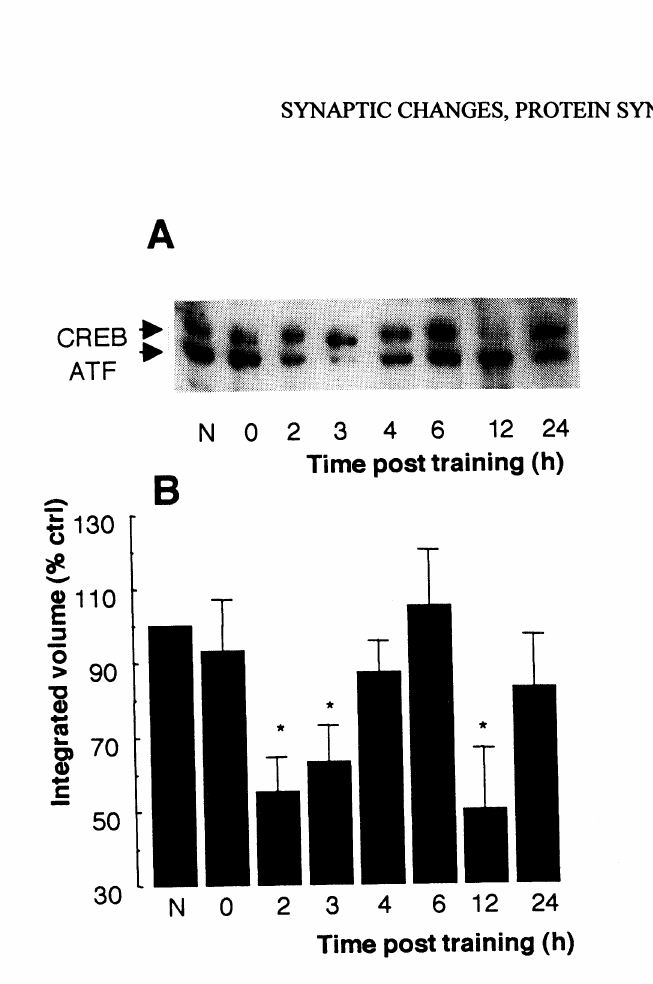
Fig. 2: Regulation of phosphoCREB expression in the hippocampal dentate gyrus following passive avoidance training. Animals were sacrificed at the indicated times post-training, the dentate gyrus was homogenised and immunoblot analysis with antibody to phosphoCREB was performed on nuclear extracts. Panel A shows a representative immunoblot. Semi-quantitative scanning densito- metry is shown in panel B, where values are normalized to % na’fve control and represent the mear+SEM (n=3). Values differing significantly from control are indicated by